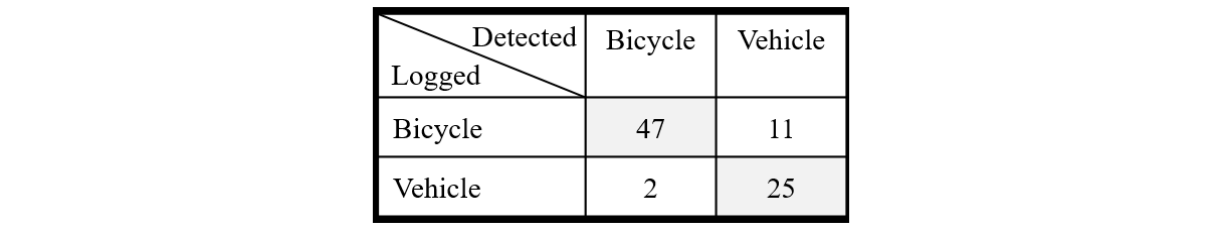
Figure 9. Classification matrix showing confusion between detection of bicycle and vehicle activities in number of